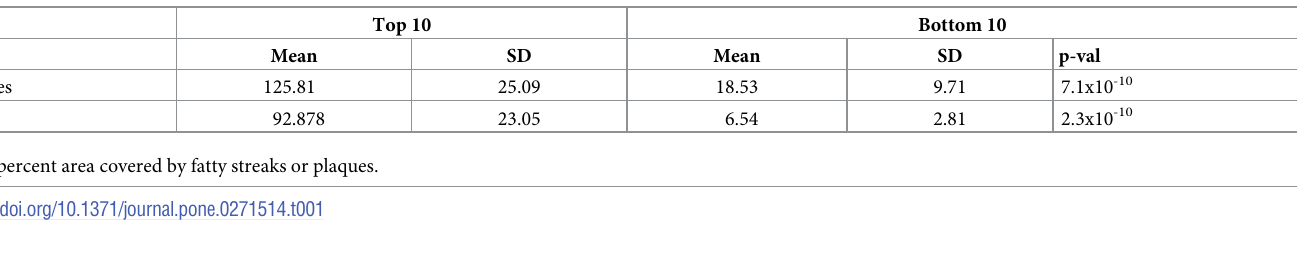
Table 1. Total lesion burden � in the top and bottom 10